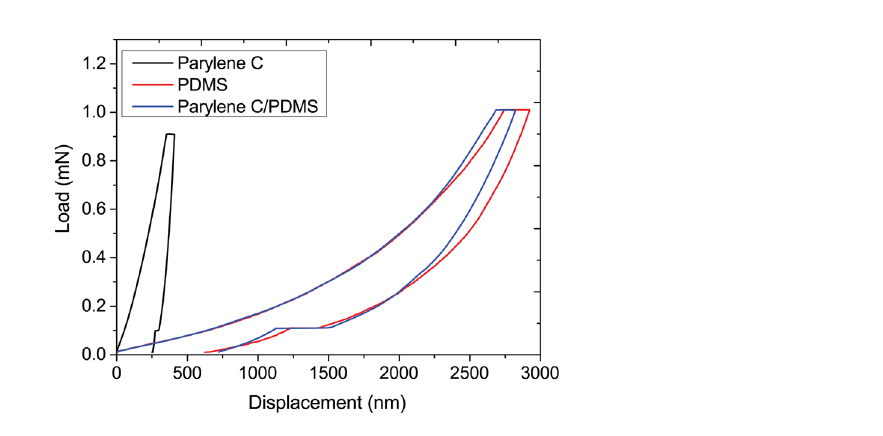
Figure 4. Typical load displacement curves. Comparison of the load-displacement curves of Parylene, PDMS and composite material at maximum load of 1 mN and loading/unloading rate of 0.2